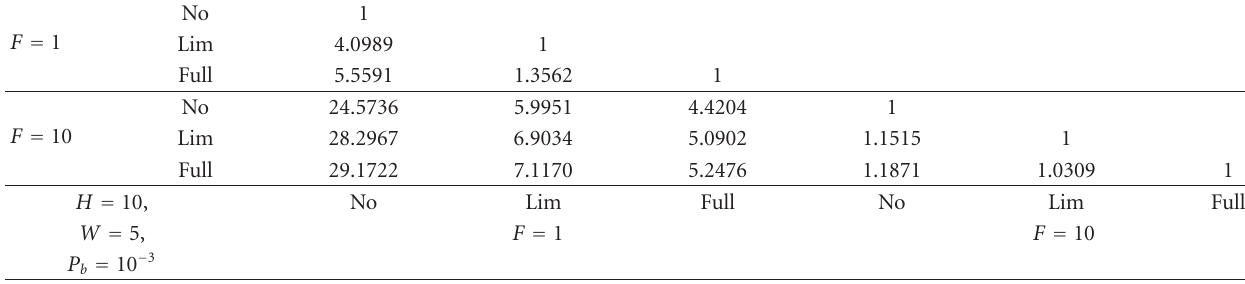
Table 3: The gain of performance, W = 5, H = 10, and P b = 10 − 3 .